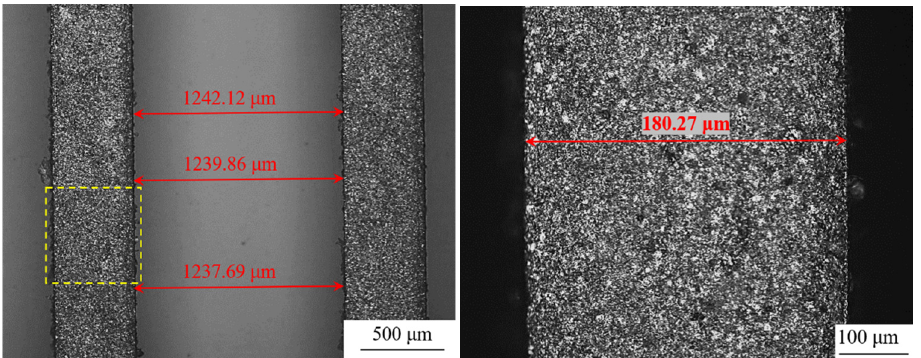
Figure 2. Straight groove shape and size of the micro-EDM.